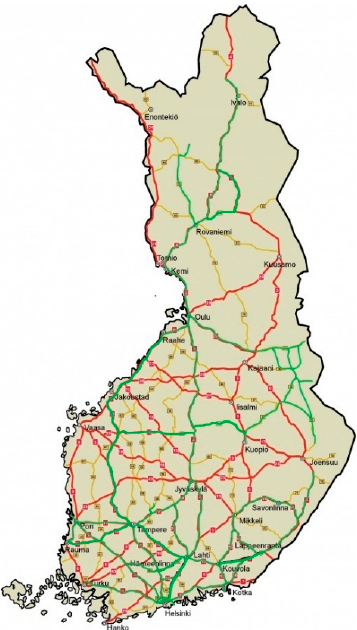
Figure 6. Highway network in Finland [54].